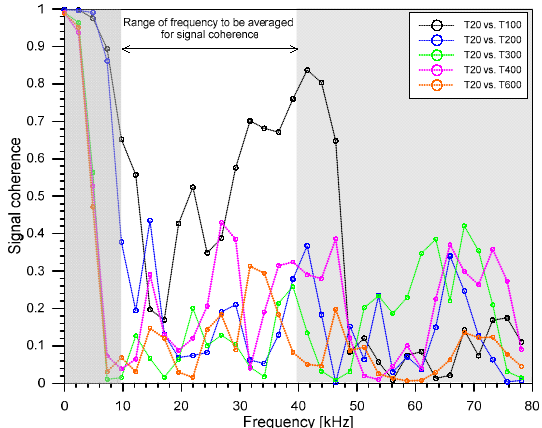
Figure 5. Frequency window for averaging magnitude squared coherence (MSC).